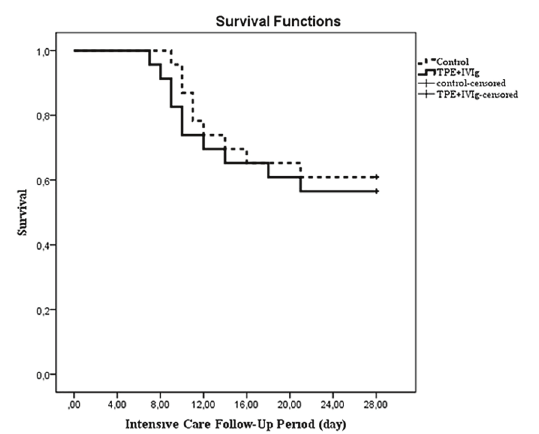
Figure 1 - Kaplan–Meier survival distributions in the TPE+IVIg and control groups patients